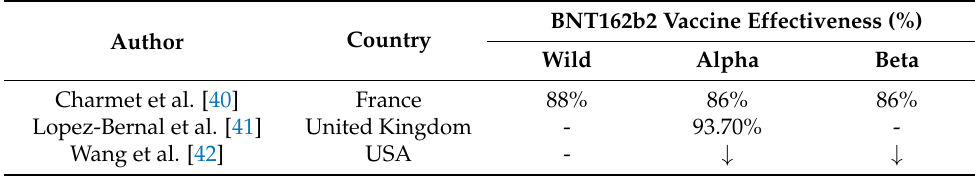
Table 4. Neutralizing capacity of antibodies generated by the administration of BNT162b vaccine against VOC of